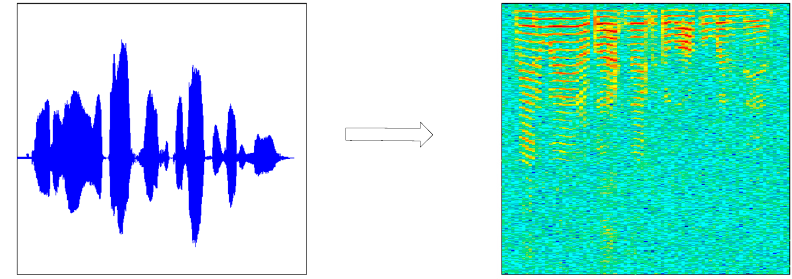
Figure 6. The speech contained in the NIST 2008 SRE dataset and the corresponding spectrogram.